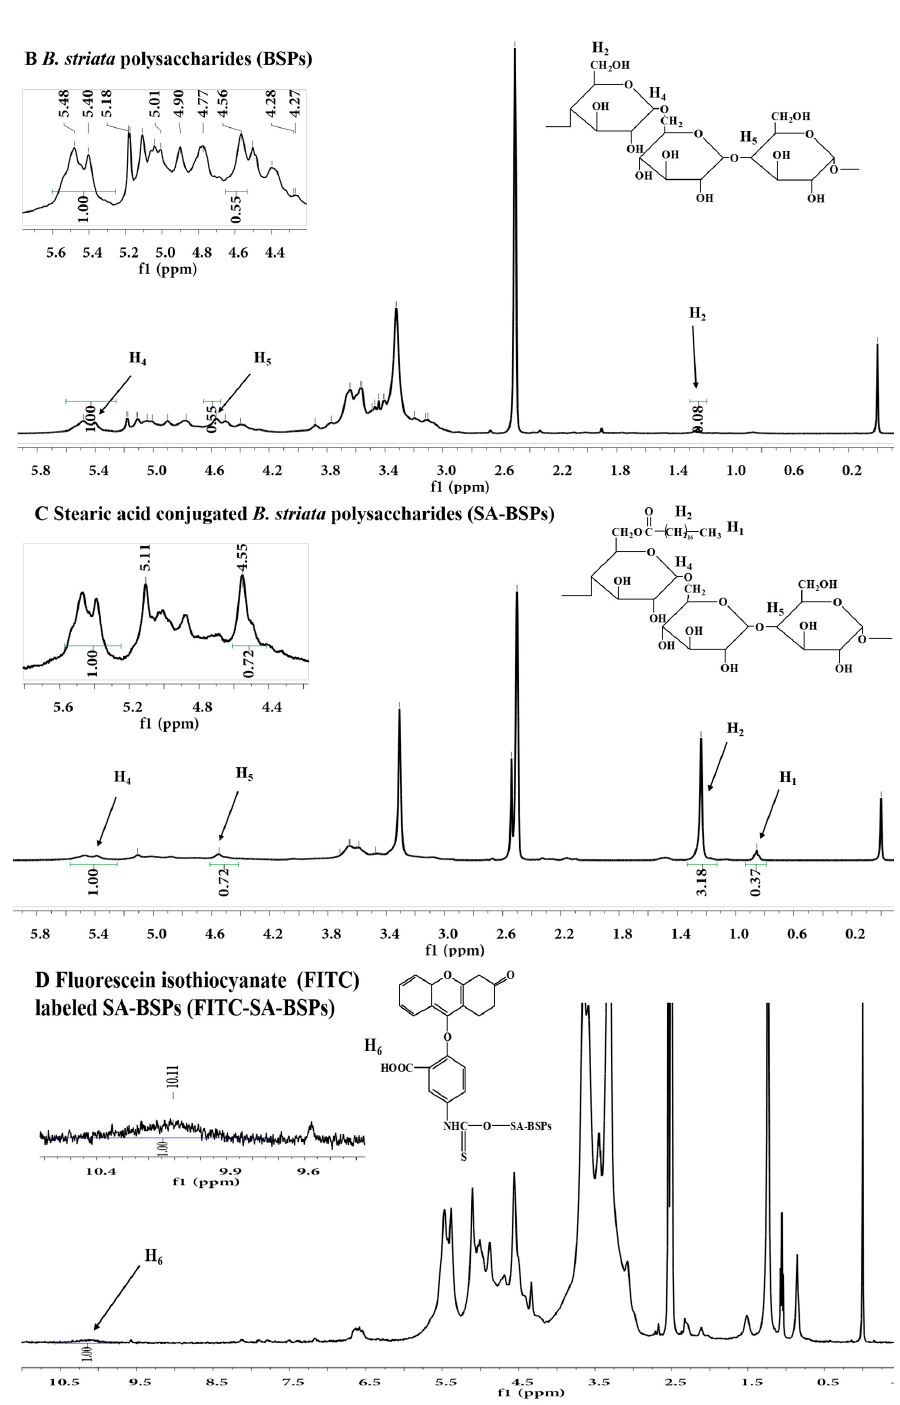
Figure 1. 1 H Nuclear Magnetic Resonance spectra of: SA ( A ); BSPs ( B ); SA-BSPs ( C ); and FITC-SA-BSPs ( D ) in DMSO- d 6 .